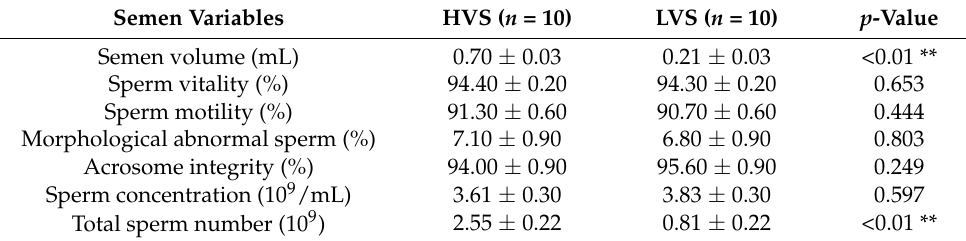
Table 2. Semen quality parameters of drakes in high- and low-volume semen